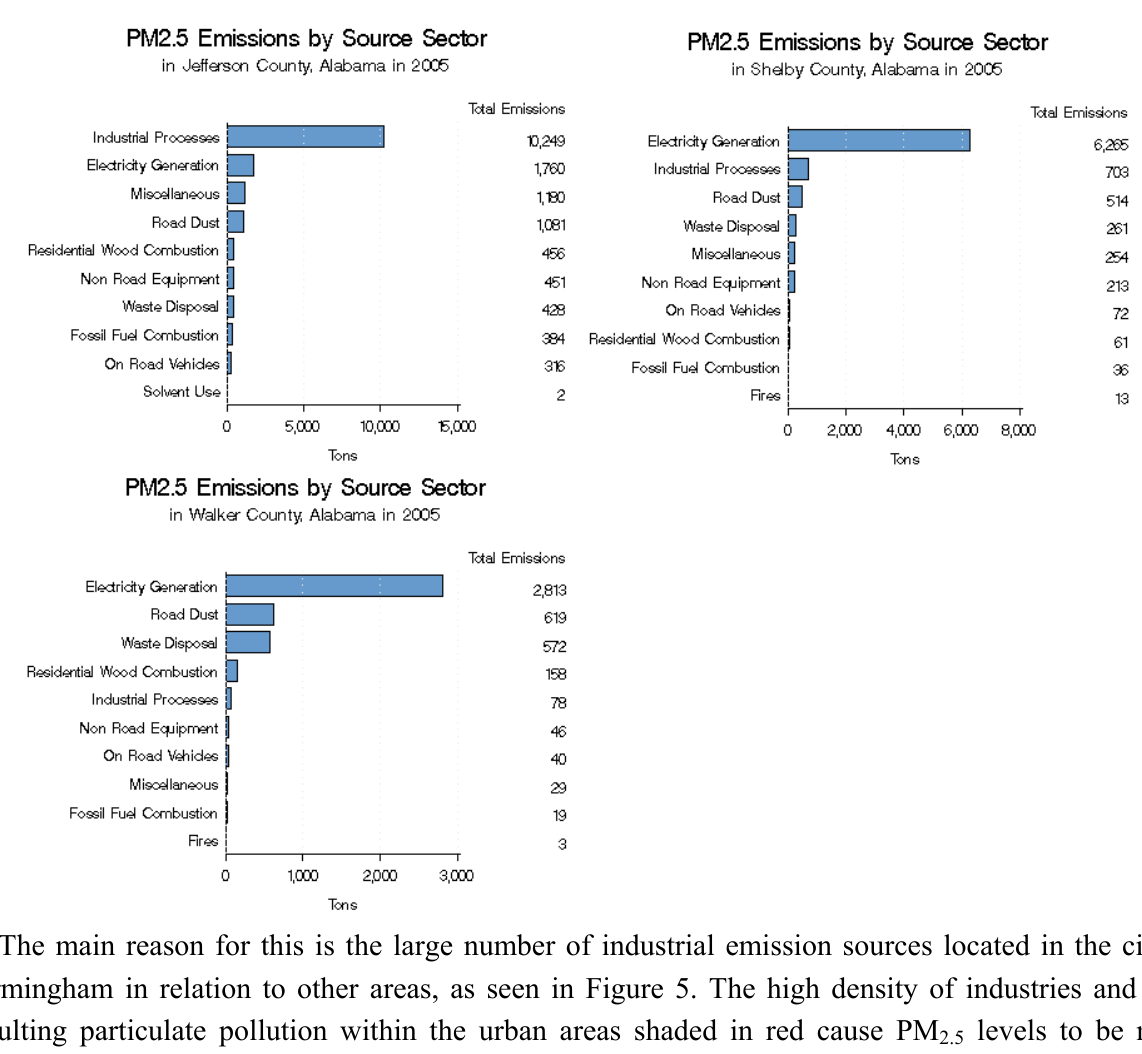
emissions by source sector for the three most polluted 2.5